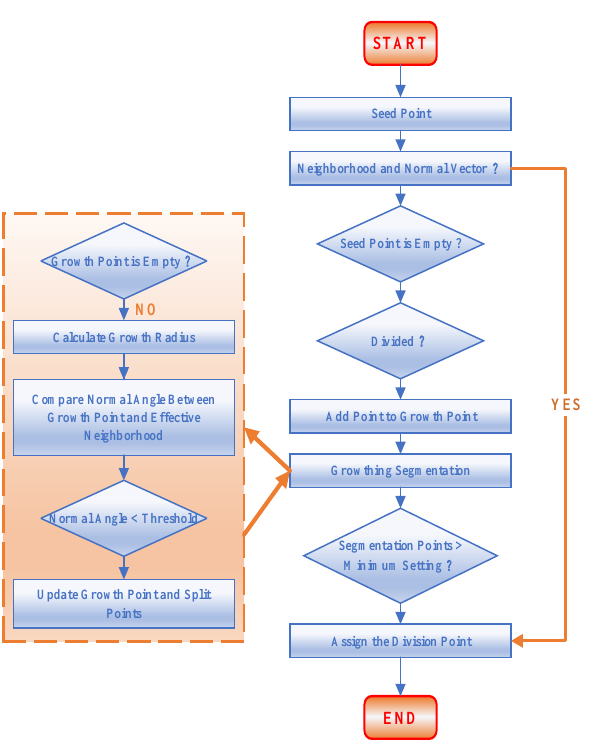
Figure 6. The workflow of the growth segmentation